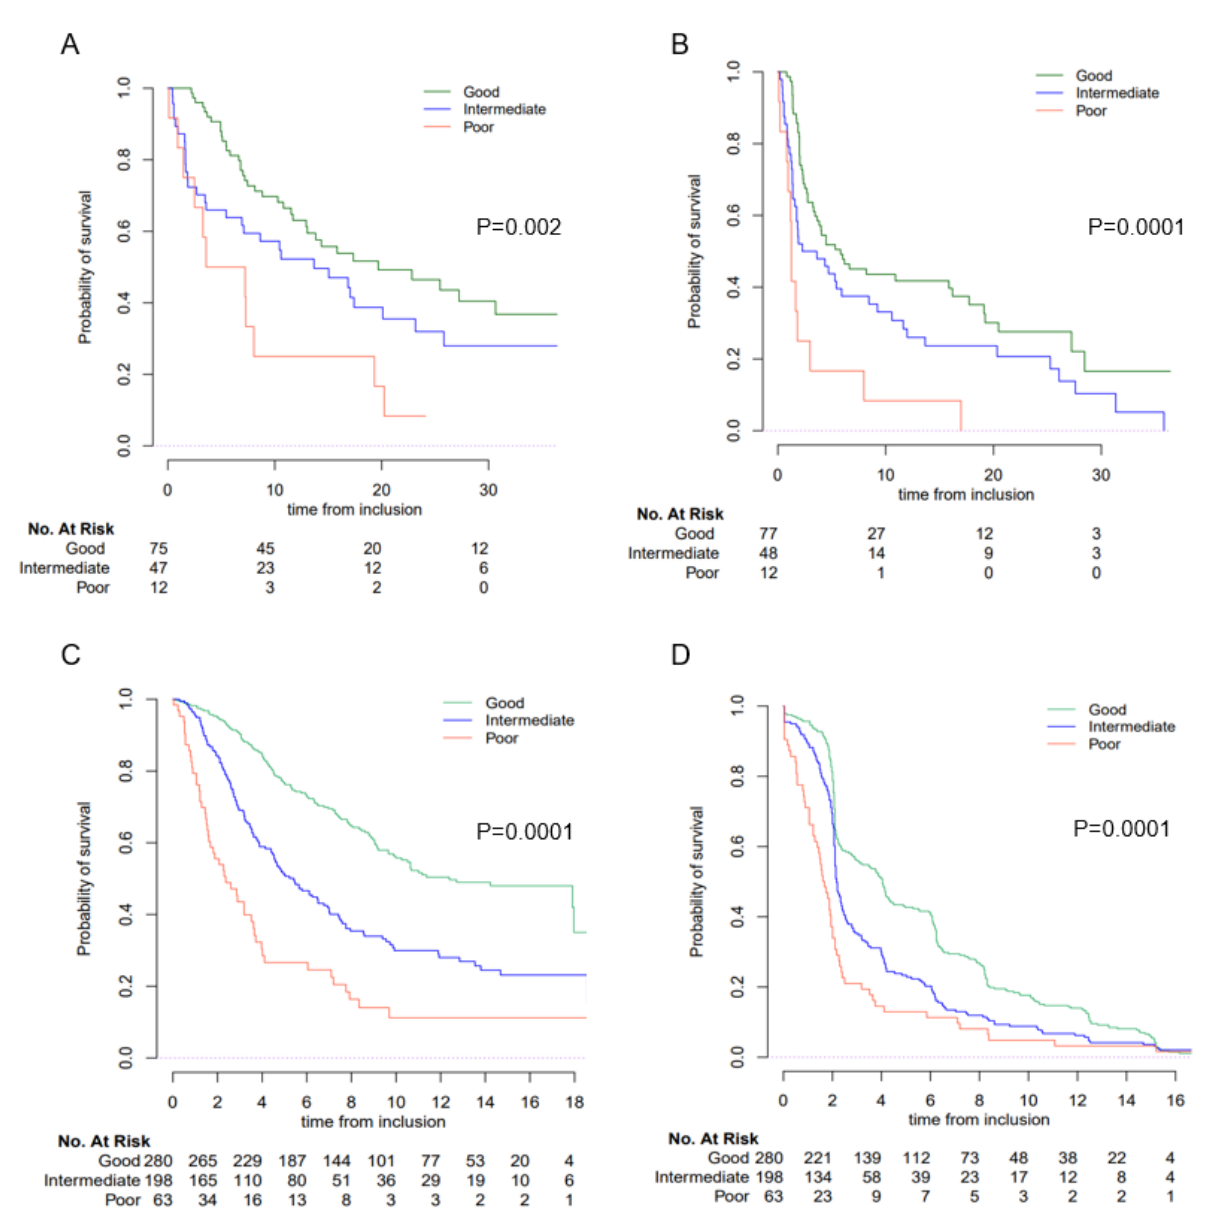
Figure 2. OS and PFS according to LIPI group in the ICI and SAUL cohorts. Overall survival (OS) and progression-free survival (PFS) according to the LIPI score. ( A ): OS in the ICI cohort, ( B ): PFS in the ICI cohort, ( C ): OS in the SAUL cohort, ( D ): PFS in the SAUL cohort. These results were confirmed in the SAUL cohort. Median OS was 8.7 mo